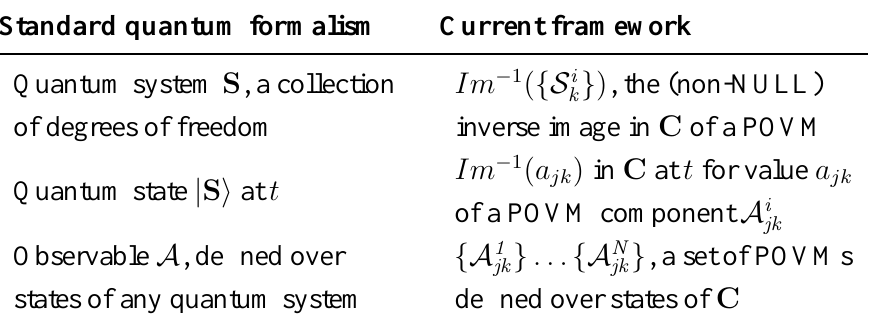
Table 1. Meanings assigned to terms in the standard quantum formalism by the current